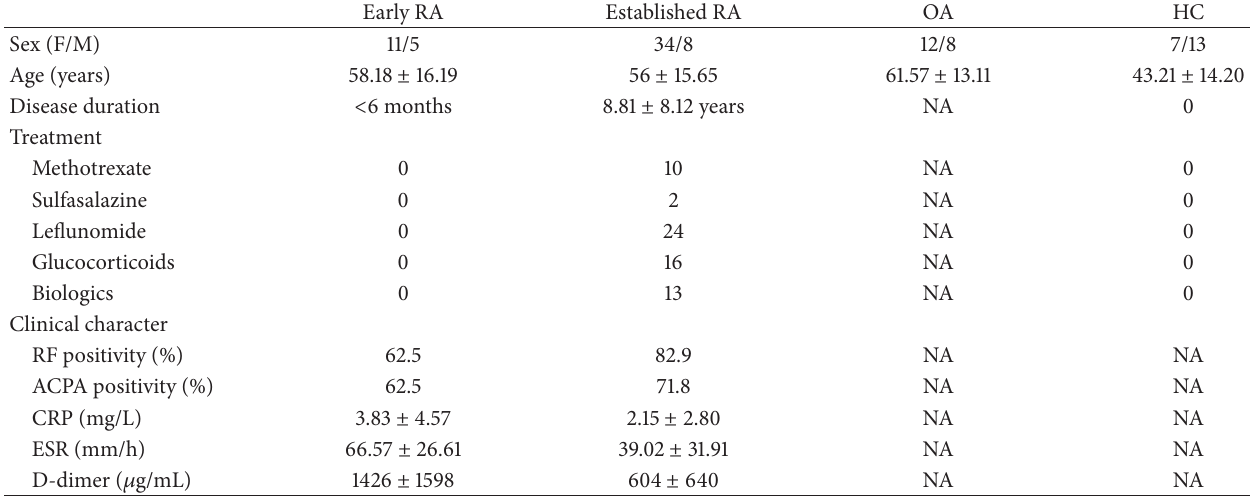
Table 1: Clinical characteristics of patients with early RA, established RA, and